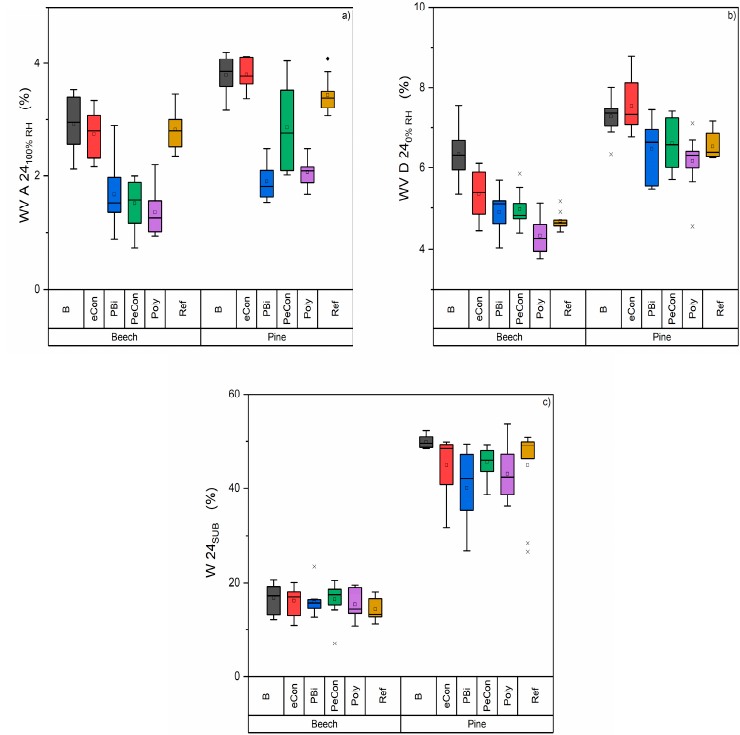
Figure 7. ( a ) Absorption ( b ) desorption of water vapor and ( c ) liquid water submersion of coated and uncoated beech and pine wood ( n = 10).